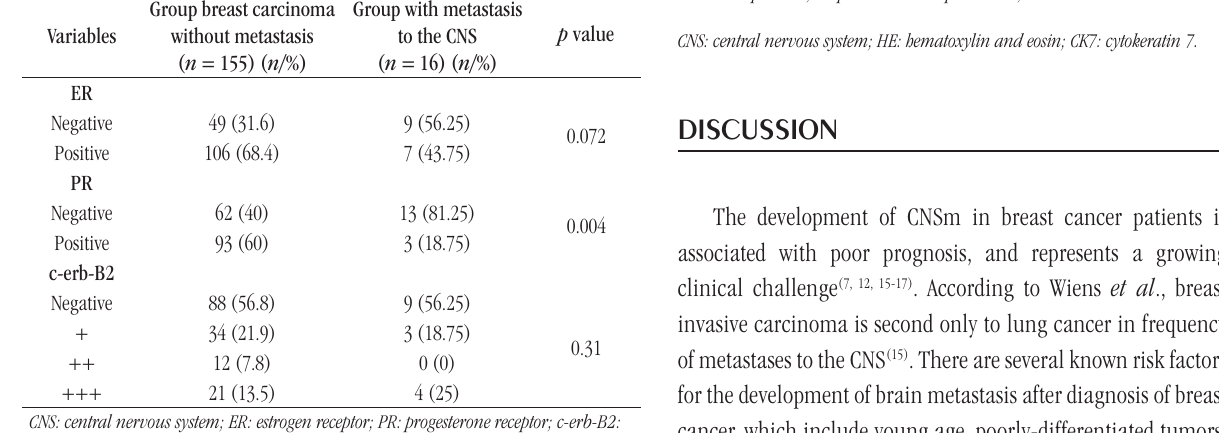
figuRE − Metastasis of breast invasive ductal carcinoma in CNS parenchyma A) invasion border of poorly-differentiated carcinoma, HE 100×; B) CK7 positive immunoexpression, streptavidin-biotin-peroxidase,